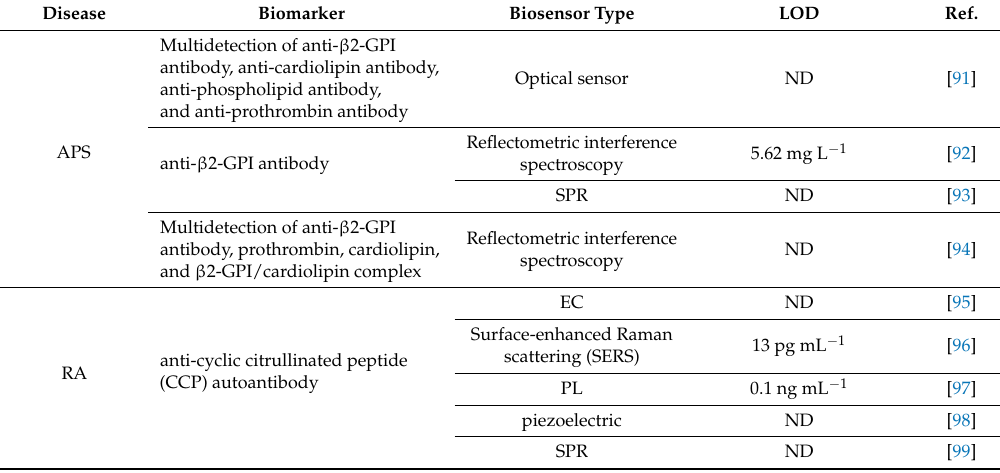
Table 2. Biosensors constructed for AID biomarker